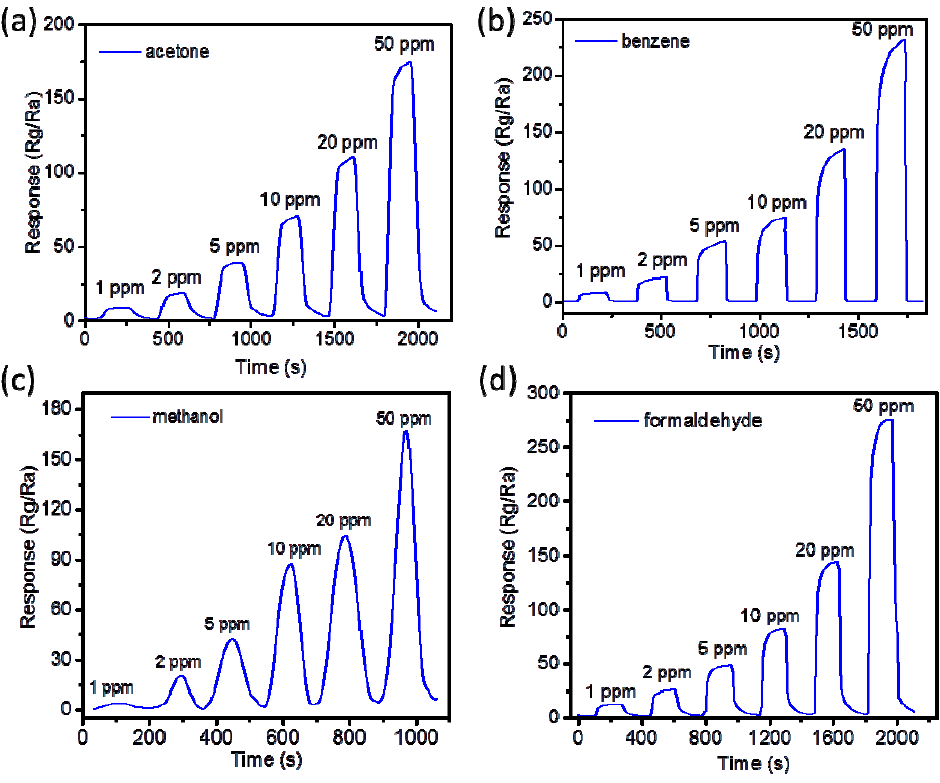
Figure 10. Rand recovery time of the: ( a ) molecular imprinted acetone sensor, ( b ) benzene sensor, ( c ) methanol sensor and ( d ) formaldehyde sensor.